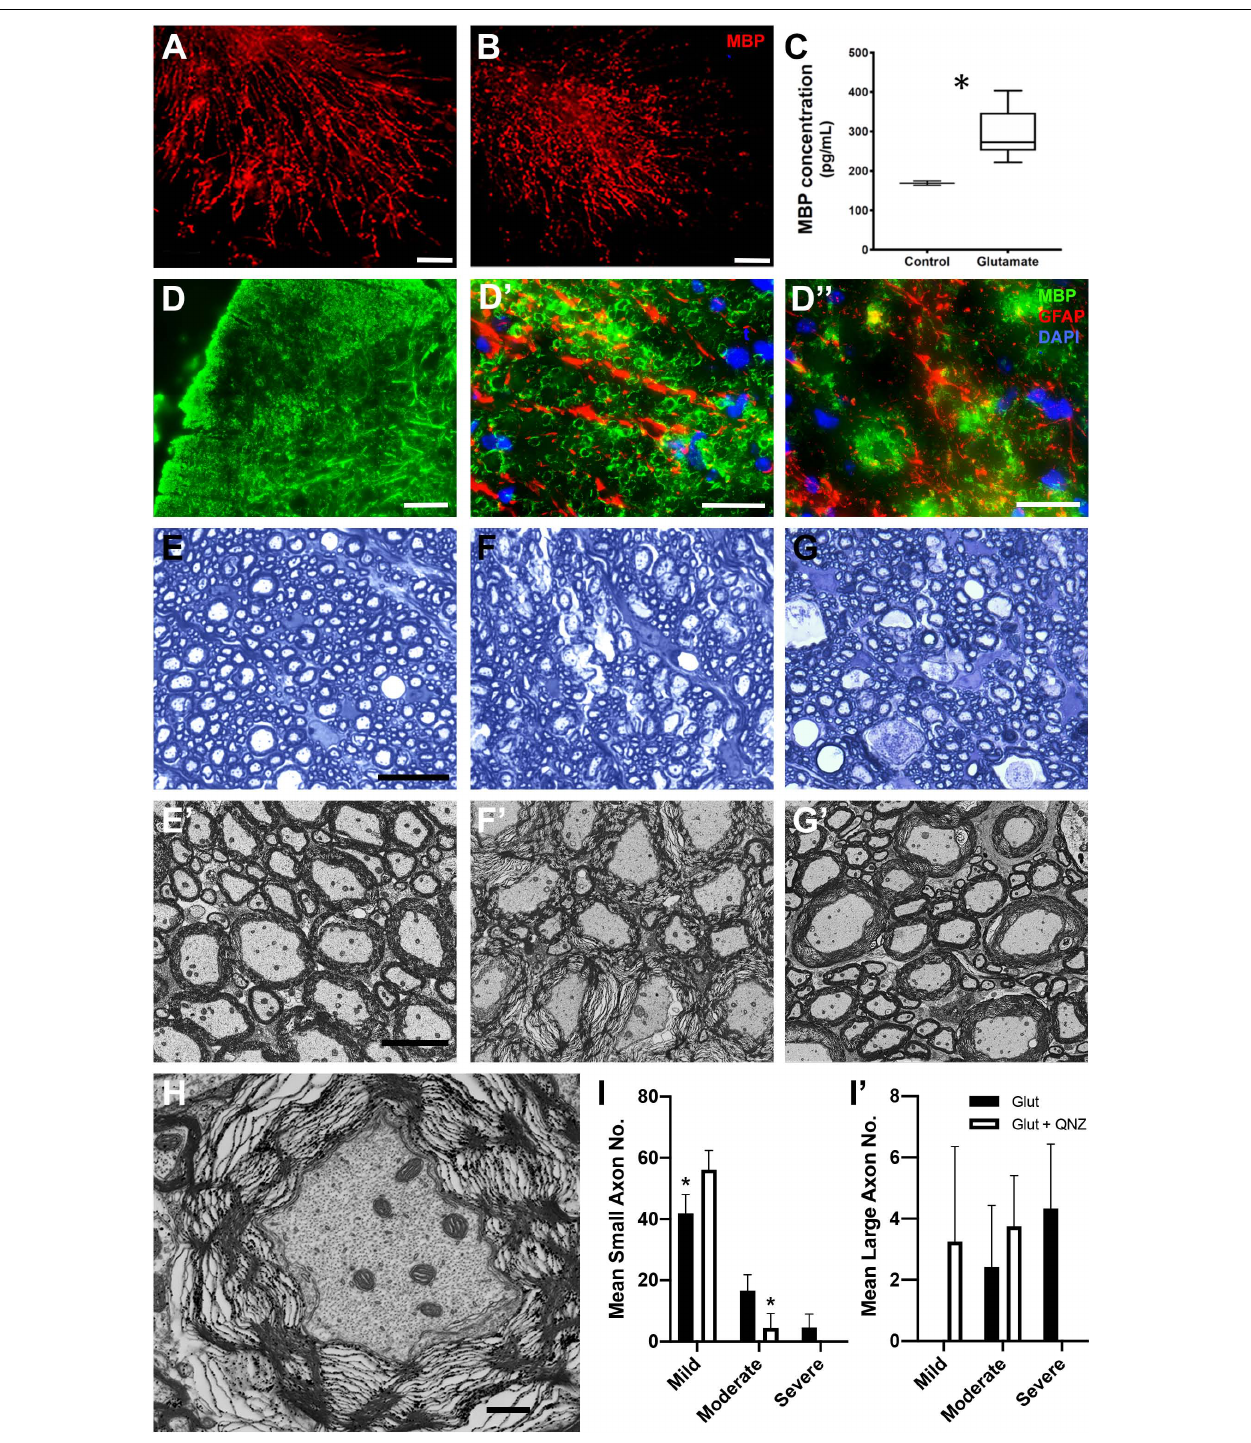
FIGURE 8 | Local elevation of glutamate in WT CNS results in local loss of myelin integrity in the presence of astrocytes. (A–C) Treatment of cerebellar slices with glutamate results in a disruption of myelin organization and a release of MBP (red). Control slices in the absence of glutamate (A) compared to parallel slices (B) treated with 100 µ M L-glutamic acid for 24 h. Note the reduction and fragmentation of the MBP processes in CID treated slices compared to controls. Quantitation of MBP by ELISA (C) in the conditioned medium of control and (12 h) glutamate treated slices. MBP levels are significantly increased following glutamate treatment. (D–J) Injection of glutamate into spinal cord white matter results in a loss of myelin integrity (MBP, green) but not astrocytes (GFAP, red). There is a loss of MBP staining in the region of glutamate injection (D) without concomitant loss of astrocytes (D’) . (D”) Astrocyte processes are retained in regions of MBP